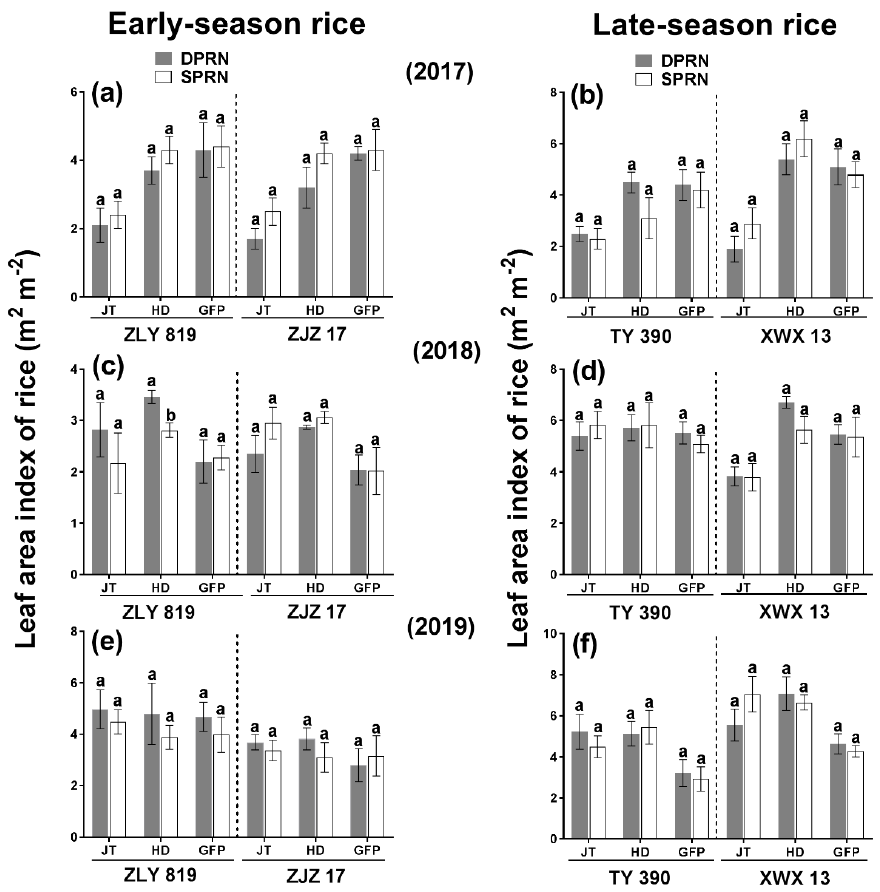
Figure 4. Leaf area index (LAI) of double-cropped rice under different treatments from 2017 to 2019. Data points represent treatment means ( n = 3), and different letters indicate significant differences ( p < 0.05). DPRN represents dense planting with a reduced nitrogen rate; SPHN represents sparse planting with a high nitrogen rate. ZLY 819 (hybrid rice) and ZJZ17 (conventional rice) belong to early-season rice cultivars; TY 390 (hybrid rice) and XWX 13 (conventional rice) belongs to late-season rice cultivars. JT represents the jointing stage; HD represents the heading stage; GFP represents the grain-filling period; ( a ) represents early − season rice in 2017; ( b ) represents late − season rice in 2017; ( c ) represents early − season rice in 2018; ( d ) represents late − season rice in 2018; ( e ) represents early − season rice in 2019; ( f ) represents late − season rice in 2019.